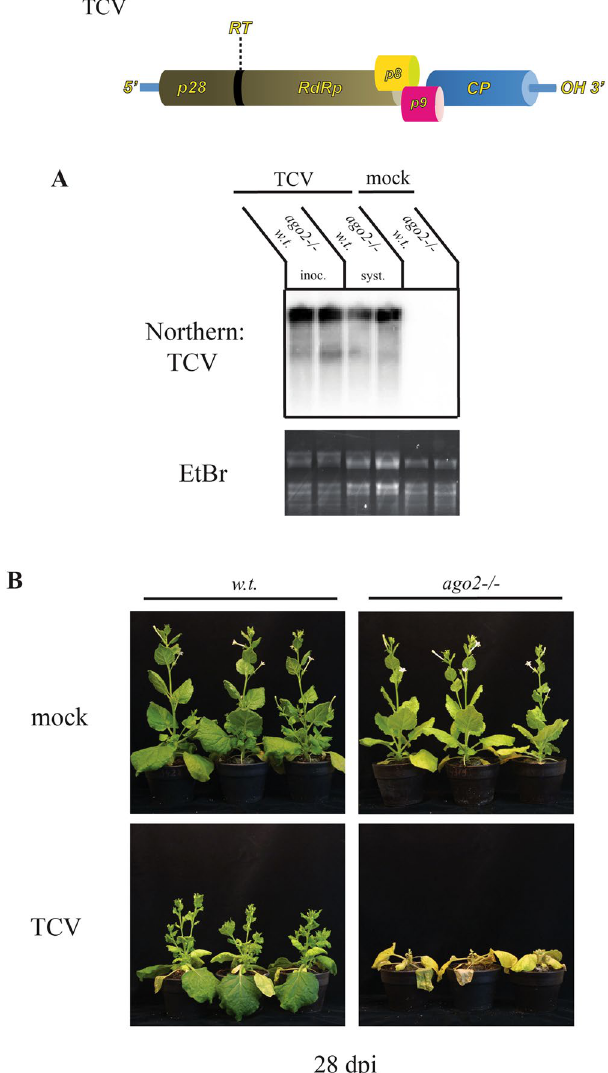
Figure 4. AGO2 deficiency exacerbates symptoms of TCV infection in N. benthamiana . ( A ) Wild-type and ago2 N. benthamiana plants were infected with in vitro transcribed full-length TCV viral transcripts. As controls, mock infections were also performed. Accumulation of TCV genomic RNA was analyzed in inoculated and systemically infected leaves at 7 dpi by northern blot. As a loading control the Ethidium- bromide stained gel is shown. ( B ) Photographs of TCV and mock infected wild-type and ago2 plants were taken at 28